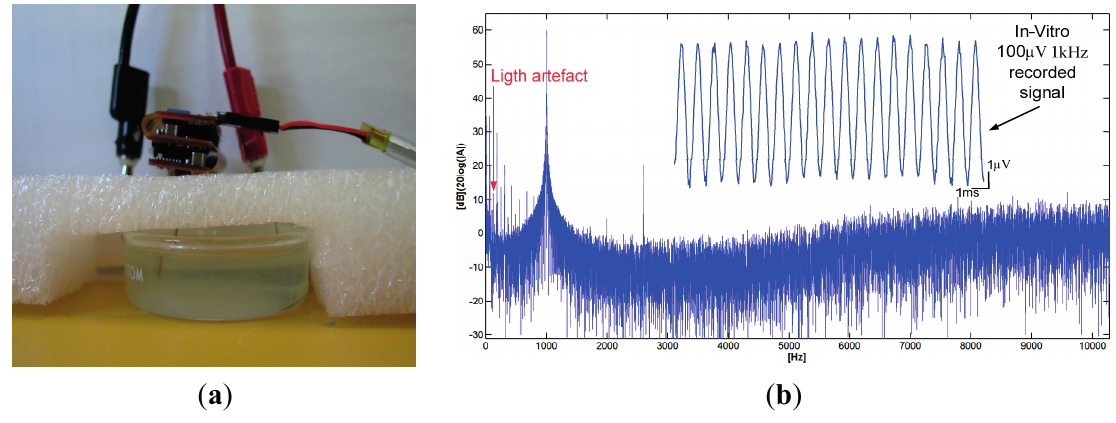
Figure 11. ( a ) In-vitro measurement setup with a 1 M saline solution; ( b ) A test waveform recorded on Channel 1 with a microelectrode within the saline solution.